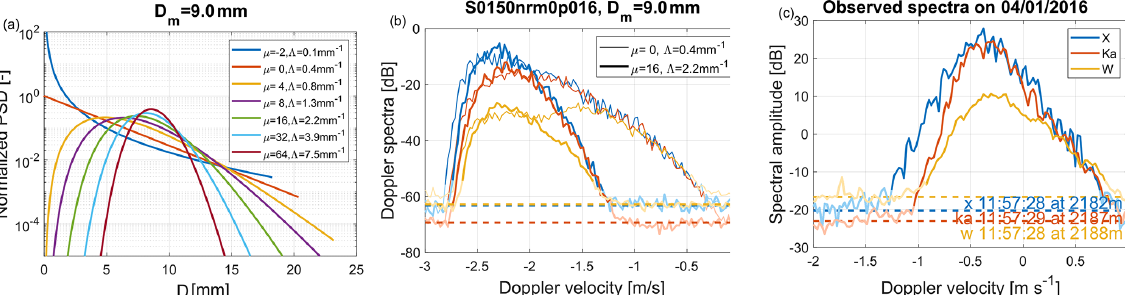
Figure 12. (a) Gamma PSDs with D m of 9mm and various shape parameters µ (see the legend for numeric values) as a function of the maximum dimension of ice particles. (b) Corresponding Doppler spectra at X, Ka and W band (see color key in c ) forward modeled using the SSRGA-plates- M 0 . 016 model, for an exponential PSD ( µ = 0, thin line) and a narrow PSD ( µ = 16, thick line). (c) Examples of observed Doppler spectra where similar D m and µ are suggested by the retrieval using the SSRGA-plates- M 0 . 016 model (see Fig. 11). In (b) and (c) , the horizontal dashed lines represent the noise level estimated from each Doppler spectrum and the portions of lines with weak color saturation highlight the parts of the Doppler spectra which are identified as